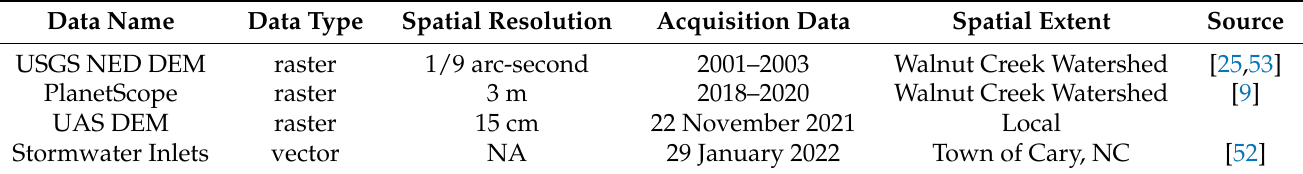
Table 6. Case Study